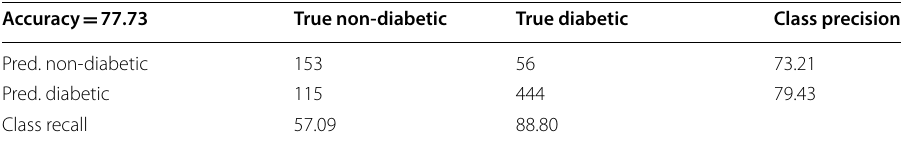
Table 3 Results of SVM Accuracy 77.73 =